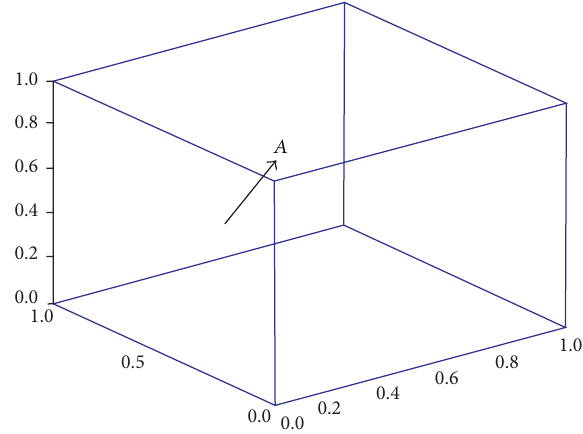
Figure2:Representationofafuzzyset 𝐴